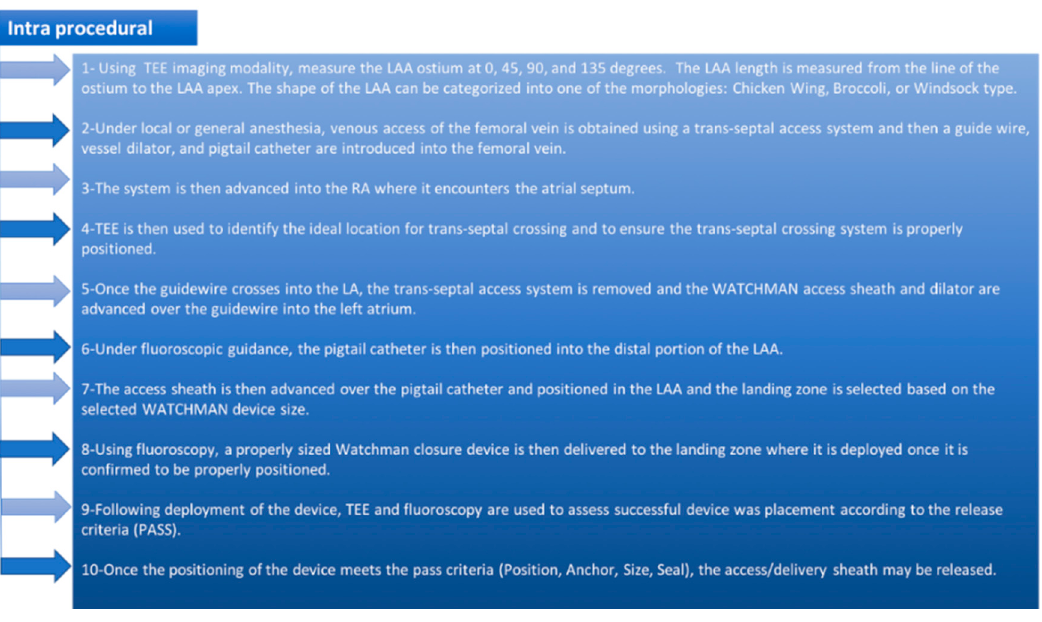
Figure 2. The WATCHMAN implant intra-procedural steps.